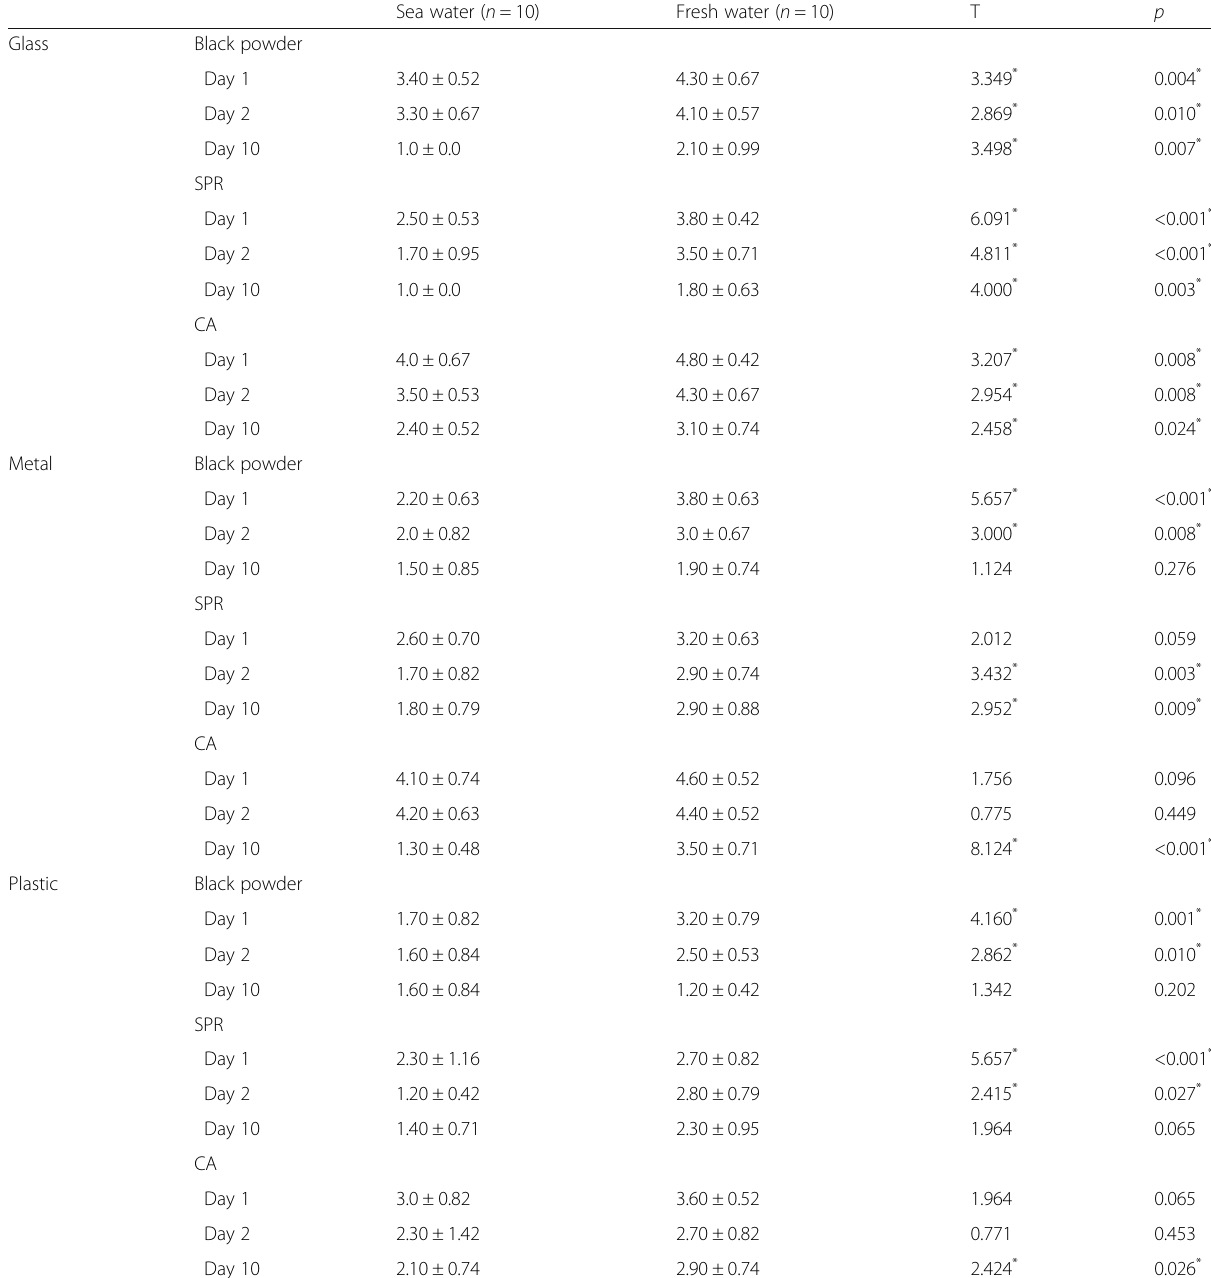
Table 7 Comparison between the mean fingerprints development scores of the studied groups according to aquatic environment and the used techniques for development of latent fingerprints from different surfaces at different time